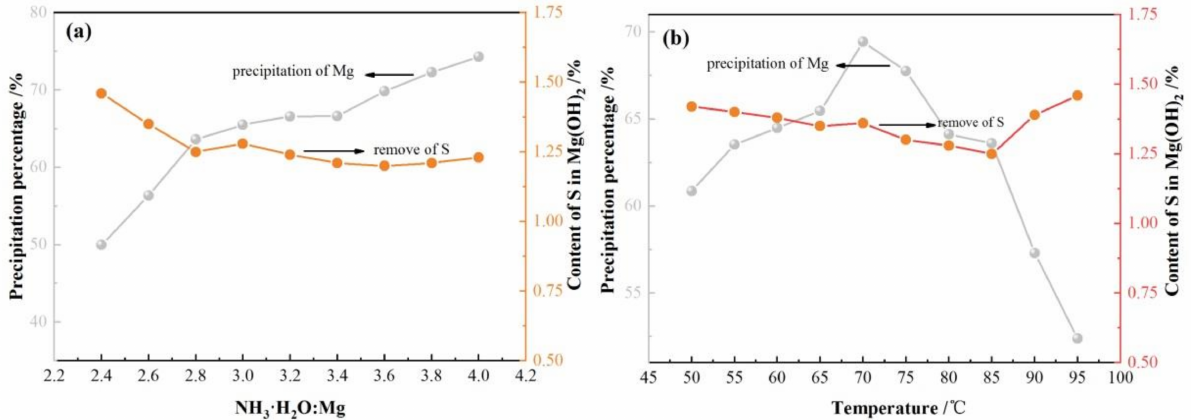
Figure 3. Precipitation percentage of Mg 2+ and S content in Mg(OH) 2 under different conditions.; ( a ) NH 3 · H 2 O:Mg; ( b ) Temperature.